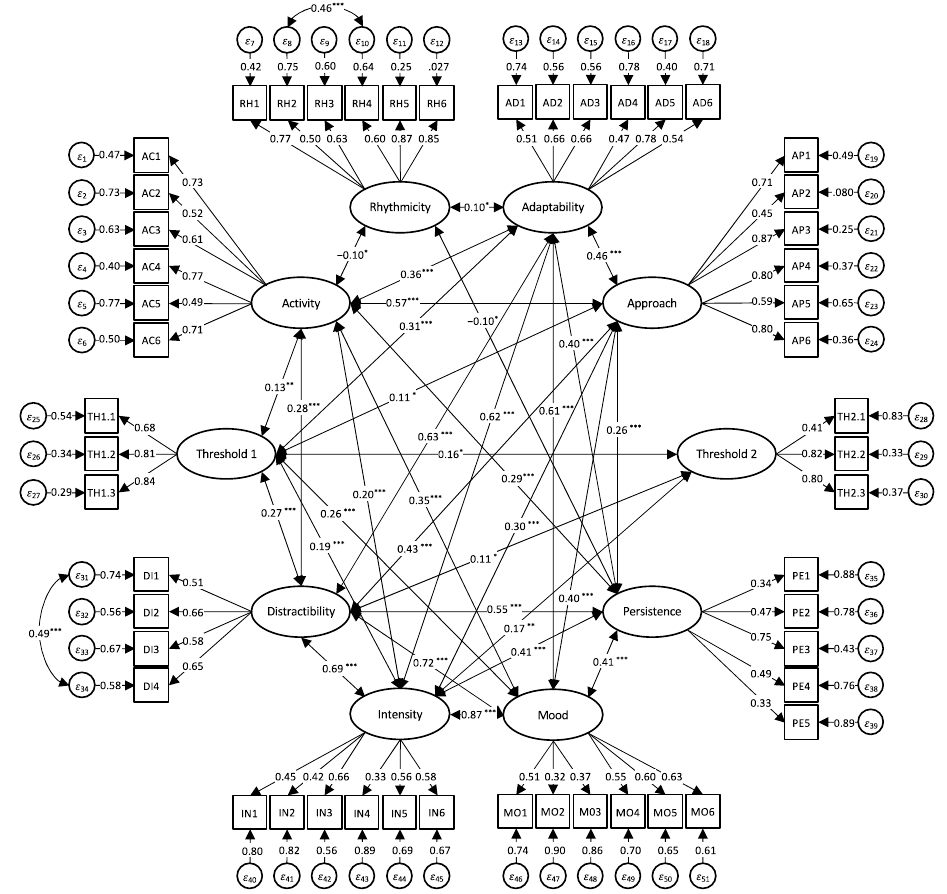
Figure 1. Standardized factor loadings and factor correlations in ATQ2 (Model 3). Note. AC = Activity; RH = Rhythmicity; DI = Distractibility; AD = Adaptability; AP = Approach; PE = Persistence; MO = Mood; IN = Intensity; TH = Threshold. All factor loadings are significant ( p < 0.001). N = 654. * p < 0.05. ** p < 0.01. *** p < 0.001.